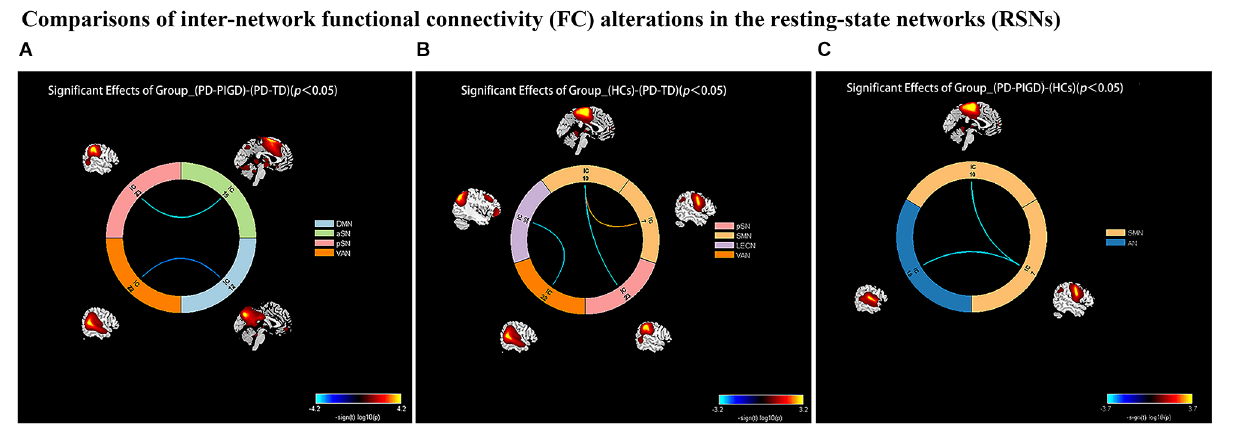
FIGURE2 Comparisons of inter-network functional connectivity (FC) alterations in the resting-state networks (RSNs) between the Parkinson’s disease (PD) with tremor dominant (TD) and postural instability and gait difficulty (PIGD) groups. (A) Compared with the PD-TD group, the PD-PIGD group exhibited a decreased connectivity between anterior salience network (aSN) and posterior salience network (pSN), and between ventral attention network (VAN) and default mode network (DMN; p < 0.05, FDR corrected). (B) Compared with the HCs group, the PD-TD group exhibited a decreased connectivity between two sensorimotor (SMN) subnetworks (IC7 and IC10); but an increased connectivity between left executive control network (LECN) and VAN, and between the SMN subnetwork (IC10) and pSN ( p < 0.05, FDR corrected). (C) Compared with the HCs group, the PD-PIGD group exhibited a decreased connectivity between two SMN subnetworks (IC7 and IC10), and between the SMN subnetwork (IC7) and auditory network (AN; p < 0.05, FDR corrected).